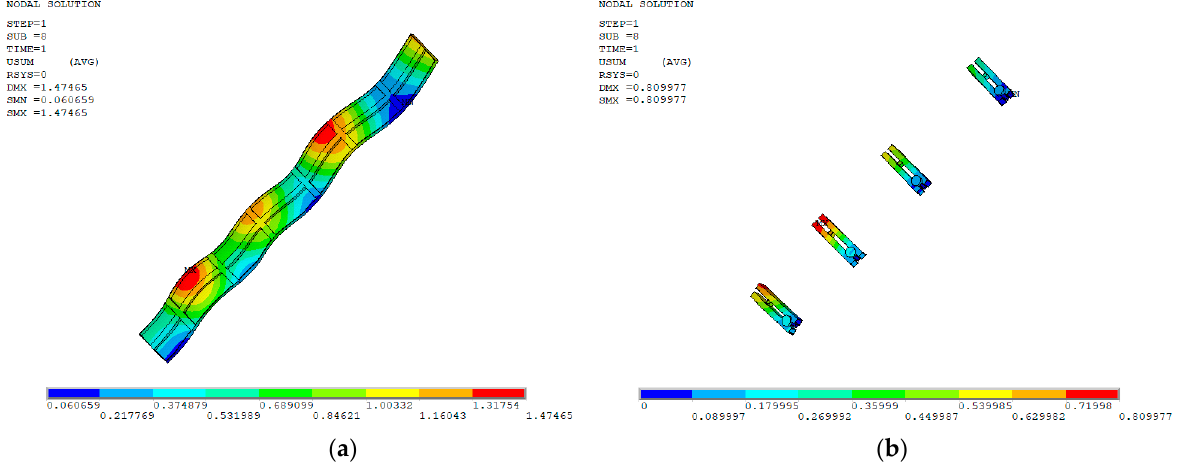
Figure 14. Strain nephogram along Z-direction: (a) Formwork; (b) Back purlin braces and Pair bolt.